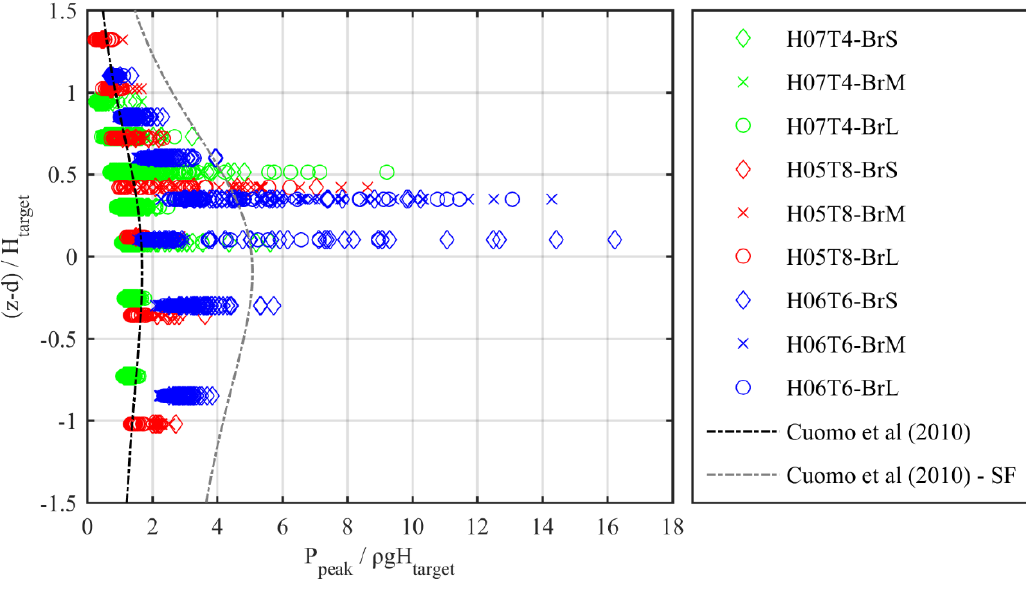
Figure 6. Distribution of pressure peaks over relative location of pressure transducers along the seawall for pulsating conditions.